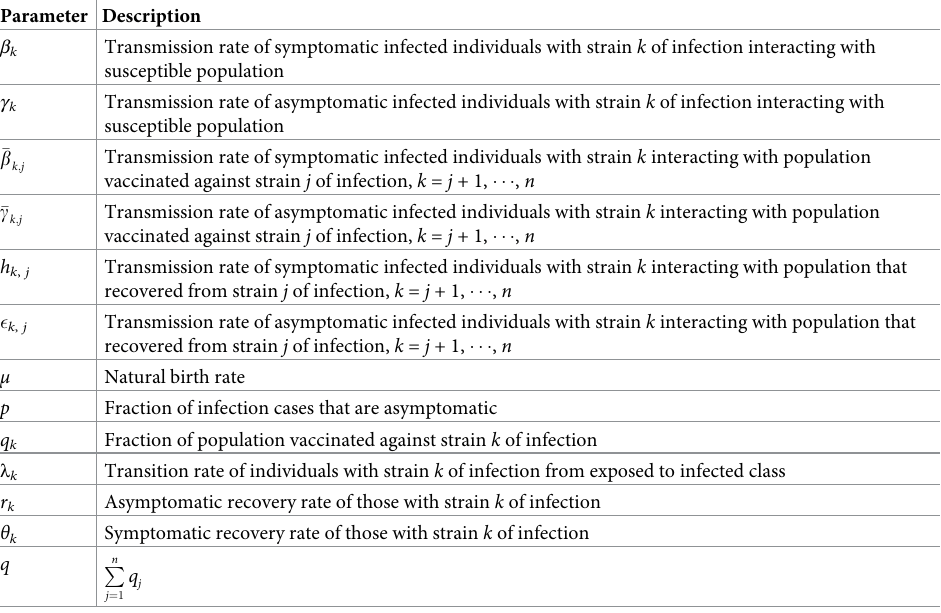
Table 2. Description of parameters for the epidemic